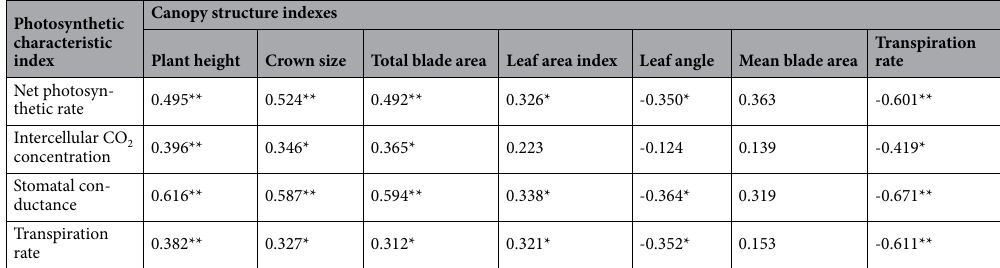
Table 4. Correlations between canopy structure and photosynthetic characteristics of peanut. *, p = 0.05; **, p = 0.01 by two-tailed Student’s t-test, n = 48.